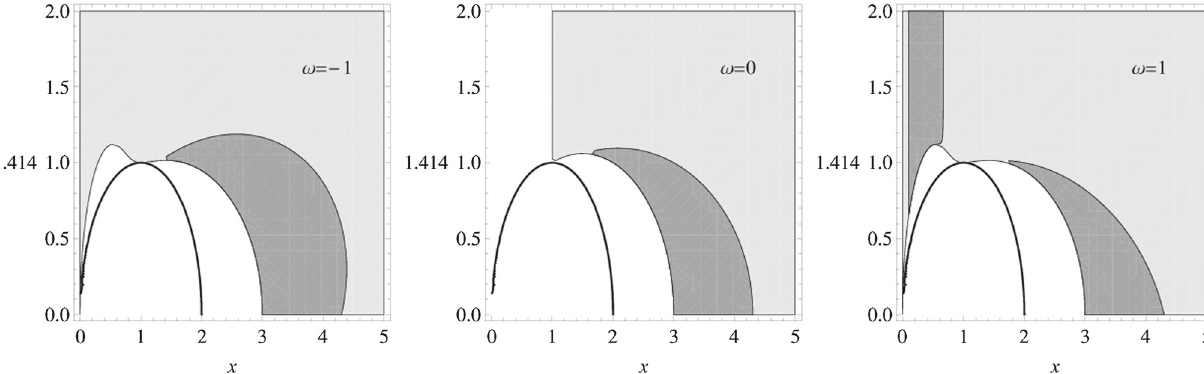
function can exist, while lighter grey colour denotes region where min- ima can exist. Only in the lighter grey areas can exist stable string loop position – the boundary between darker/light areas act as innermost stable string loop position. In white areas above RN black hole horizon there are no extrema point of V eff